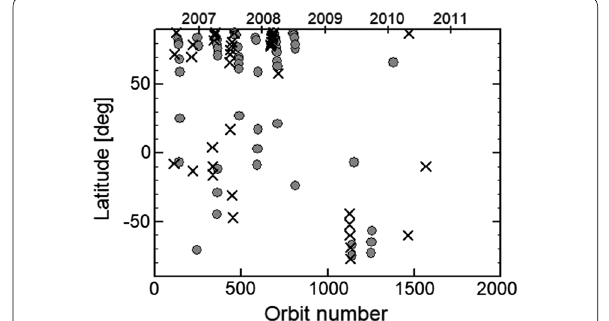
Fig. 3 The latitudes of selected SOIR occultations are plotted as a function of the VEX orbit number. The corresponding first days of each Earth year are given at the top of the figure. The dots ( ● ) are for morning solar occultations, while the crosses ( solar occultations. There is one orbit per Earth day. There are 128 occultations considered in this work. The data cover the period from 2006 to 2010